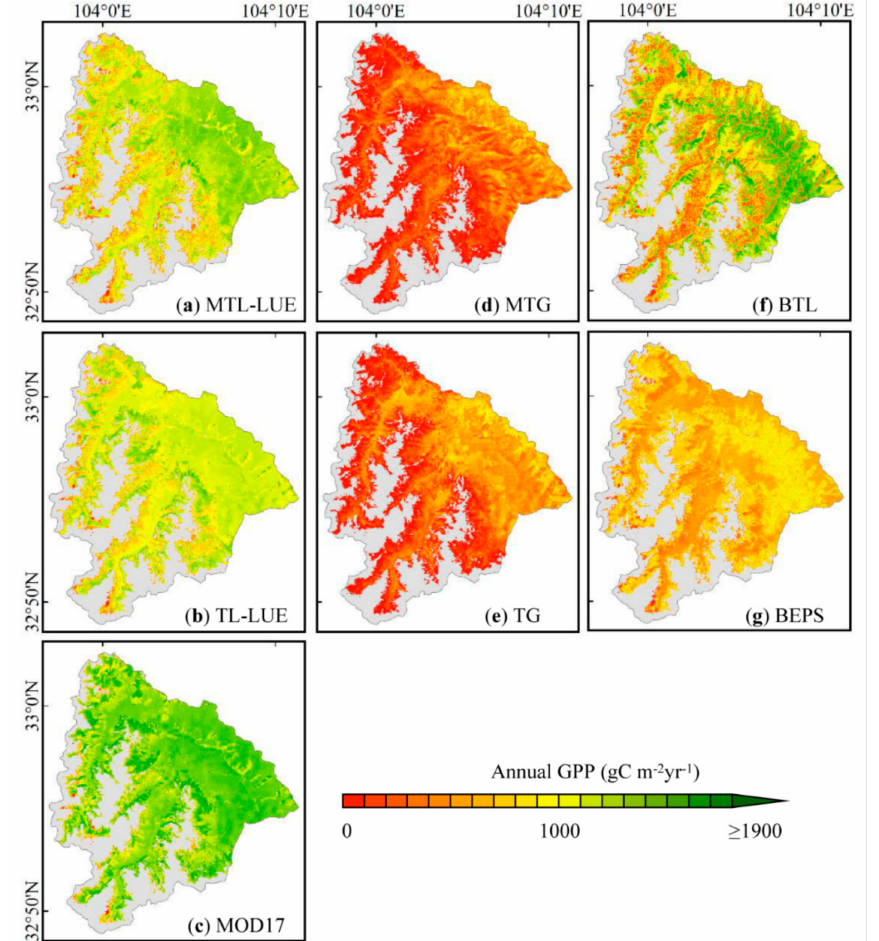
Figure 3. Spatial distributions of annual GPP MTL-LUE ( a ), GPP TL-LUE ( b ), GPP MOD17 ( c ), GPP MTG ( d ), GPP TG ( e ), GPP BTL ( f ), and GPP BEPS ( g ) over Wanglang Reserve. The annual values were summed from those daily (i.e., MOD17, TL-LUE, MTL-LUE, BEPS, and BTL) or 8-day (i.e., TG and MTG) estimates during DOY 1–273 in